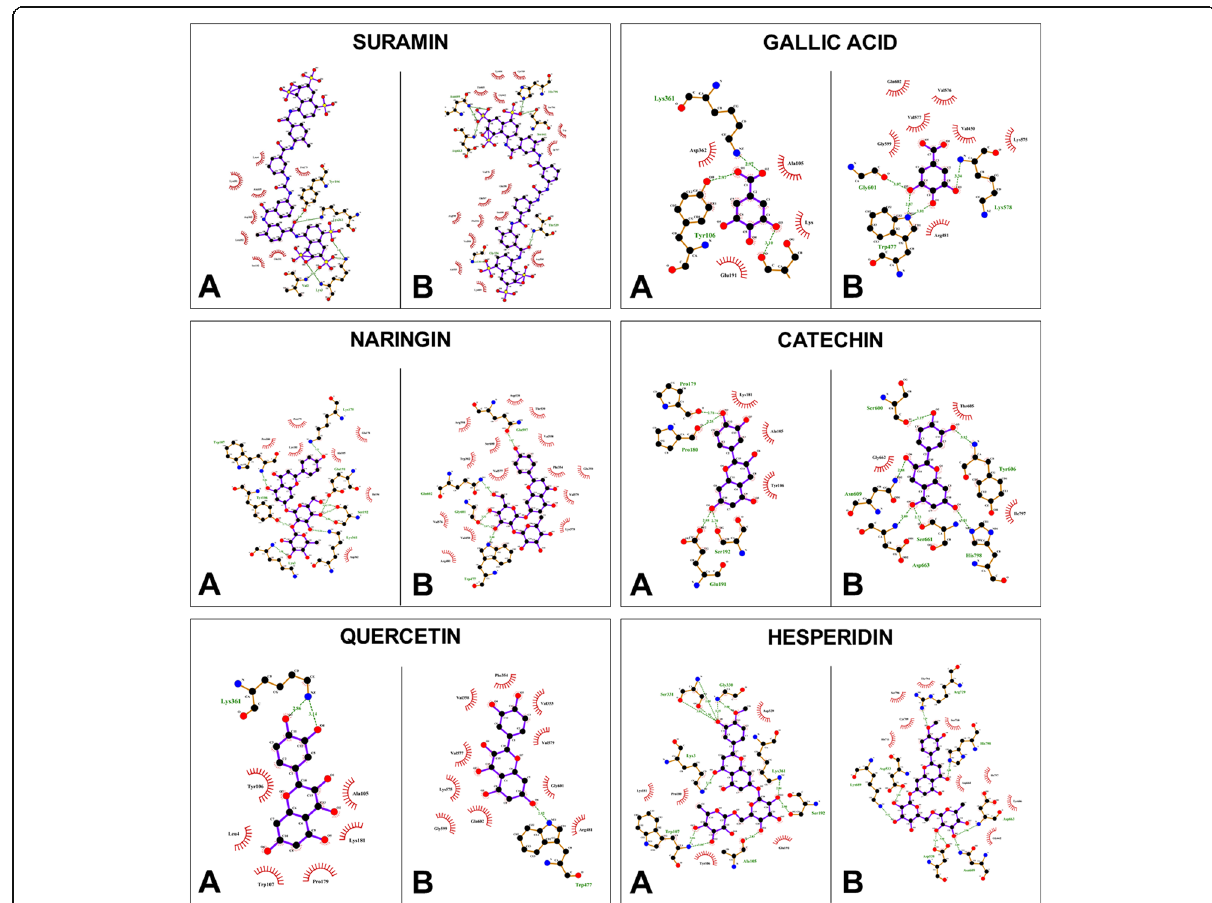
Fig. 6 Protein interactions with the compounds isolated from the Pg -YP-I-22C fraction. a . Interactions of viral Protein E with the compounds. b . Interactions of viral Protein NS5 with the compounds. Hydrogen bond interactions are represented by dashed lines in green, and their distances are indicated (Å). Hydrophobic interactions are represented as red eyelashes. The names and numbers in the residues correspond to the target proteins. Images obtained using LigPlot+